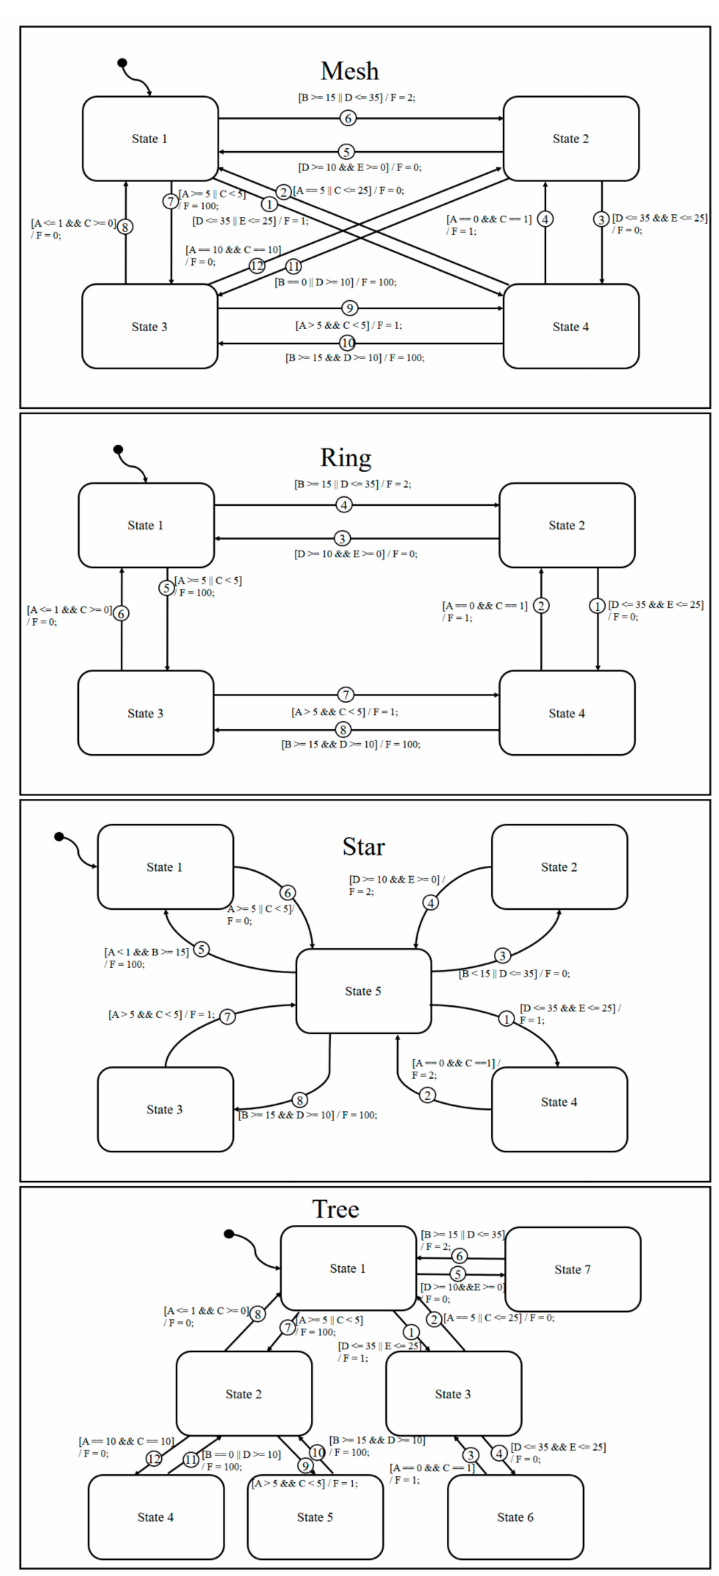
Figure 6. State-chart case